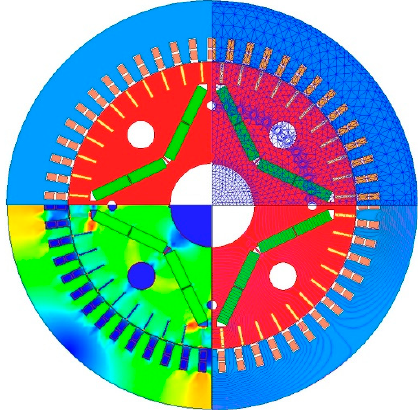
Figure 10. HVLSPMSM FEA model. Table 1. Parameters of the HVLSPMSM.